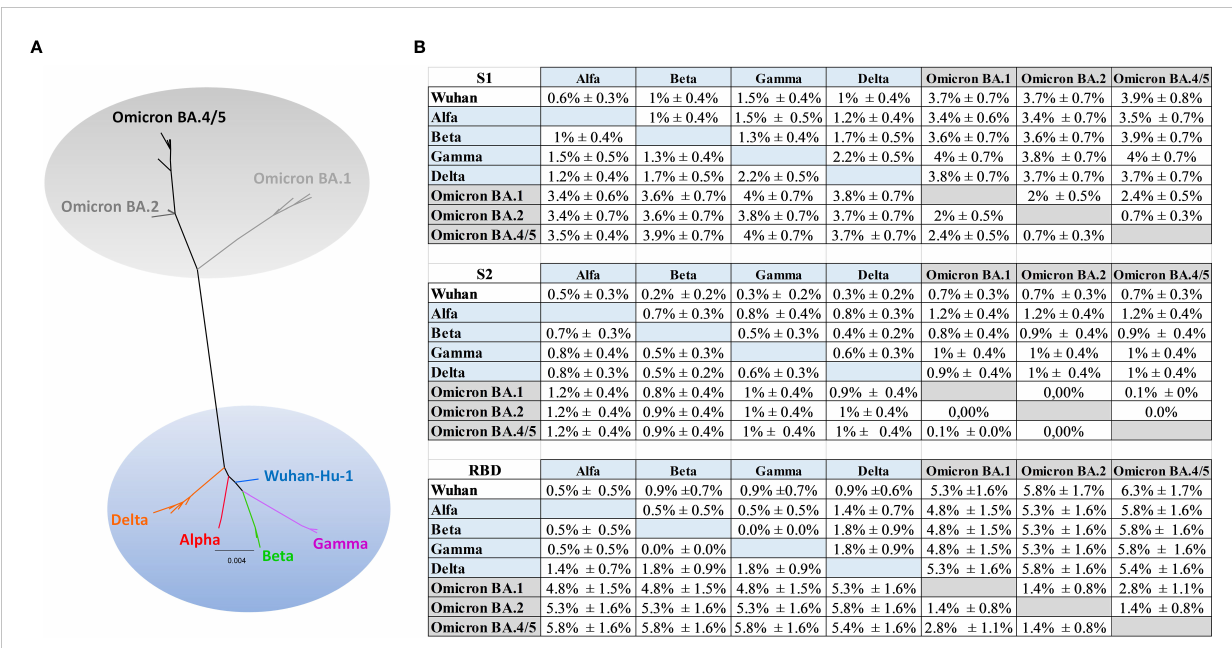
FIGURE 7 Phylogenetic analysis. (A) Maximum likelihood phylogenetic tree inferred from Spike amino acid sequences. The ancestral SARS-COV-2 sequence (Wuhan/Hu- 1/2019), the Alpha, Beta, Gamma, Delta and the Omicron (BA.1, BA.2, BA.4/5) variants are highlighted with different colors. The scale bar at the bottom of the tree corresponds to amino acid substitutions per site. The authors, originating and submitting laboratories of the sequences from GISAID used to generate the fi gures are listed in Supplementary Table 1. (B) Mean distances ± SEM at amino acid level for S1, S2 and RBD.